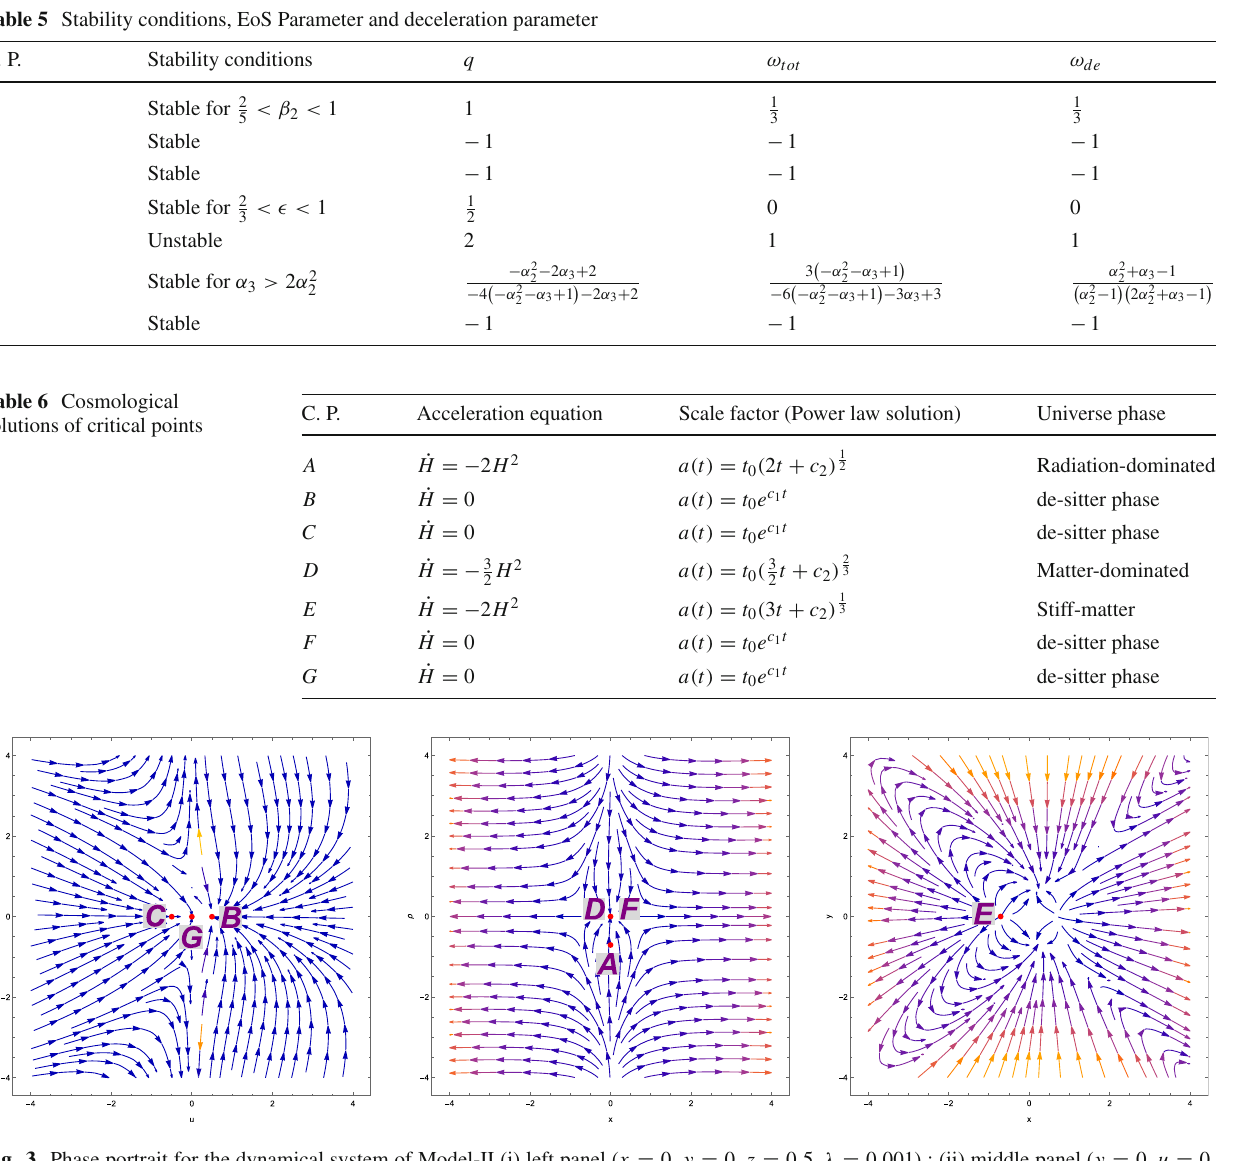
Fig. 3 Phase portrait for the dynamical system of Model-II (i) left panel ( x = 0, y = 0, z = 0 . 5, λ = 0 . 001) ; (ii) middle panel ( y = 0, u = 0, z = 0 . 5, λ = 0 . 001) (ii) right panel ( u = 0, ρ = 0, z = 0 . 5, λ = 0 .